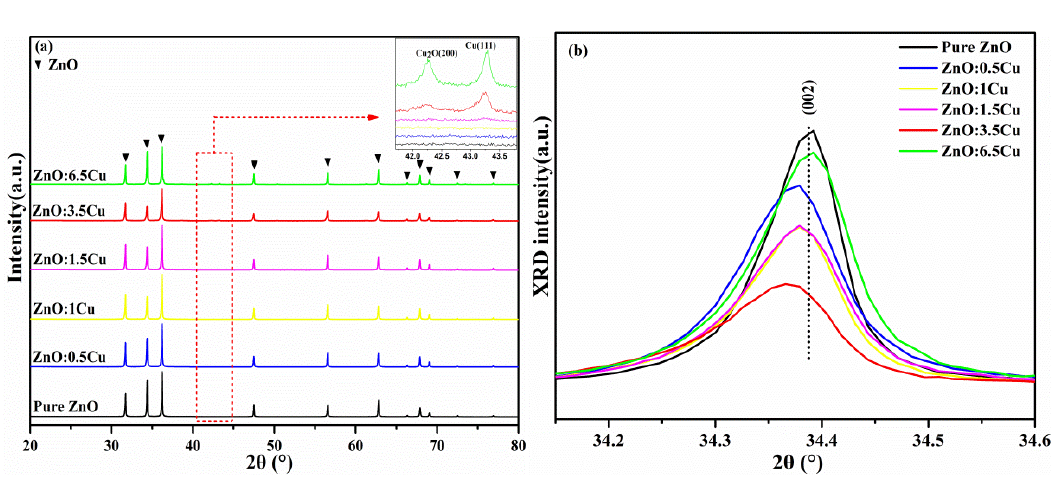
Figure 3. XRD patterns of the calcined ZnO:XCu model catalysts ( a ) and the diffraction peak of the ZnO (002) plane ( b ).